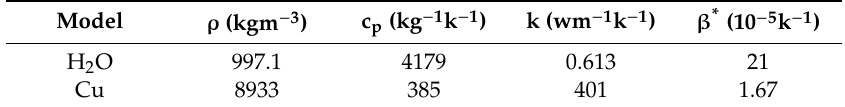
Table 3. Thermophysical